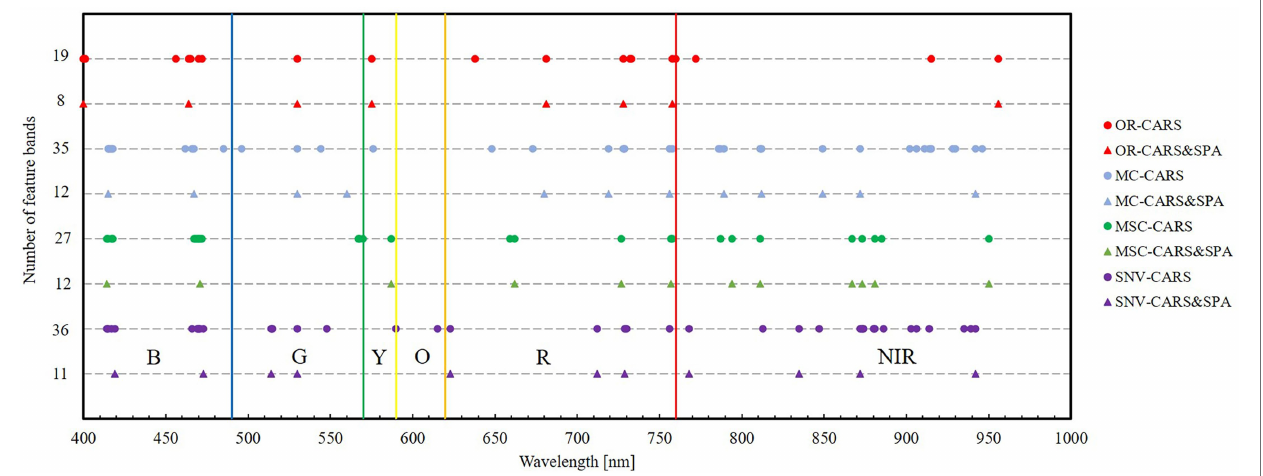
TABLE 2 | Results of feature band selection for four different spectral transformation methods. Spectrum transform Optimum band selection using SPA on the base of OR